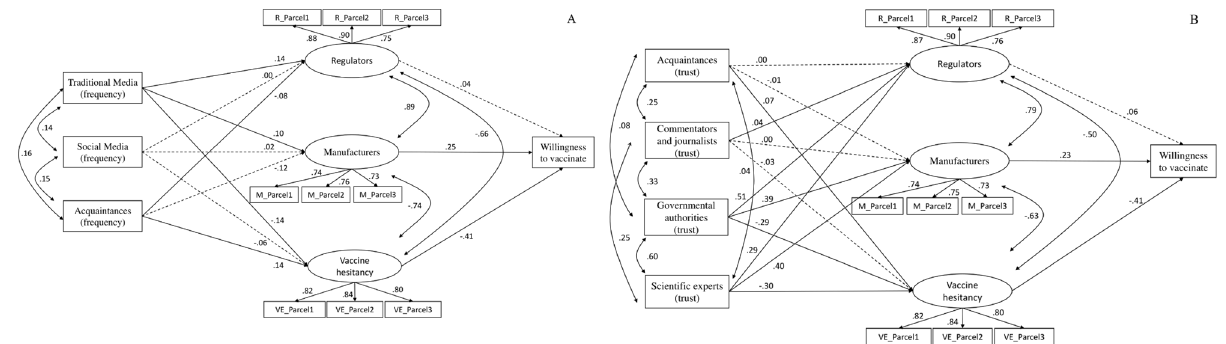
Figure 4. The impact of media channels ( A ) and trust in information sources ( B ) on willingness to vaccinate. ( A ) Fit indexes: χ 2 test of model fit = 723.70; df = 51 (p < 0.001); Comparative Fit Index (CFI) = 0.966; Root Mean Square Error of Approximation (RMSEA) = 0.057 (90% CI 0.053–0.060); Standardized Root Mean squared Residual (SRMR) = 0.026). Scaling Correction Factor for MLR = 1.16. ( B ) Fit indexes: χ 2 test of model fit = 769.81; df = 58 ( p < 0.001); Comparative Fit Index (CFI) = 0.968; Root Mean Square Error of Approximation (RMSEA) = 0.055 (90% CI 0.051–0.058); Standardized Root Mean squared Residual (SRMR) = 0.025). Scaling Correction Factor for MLR = 1.16. All other conventions as in Fig.